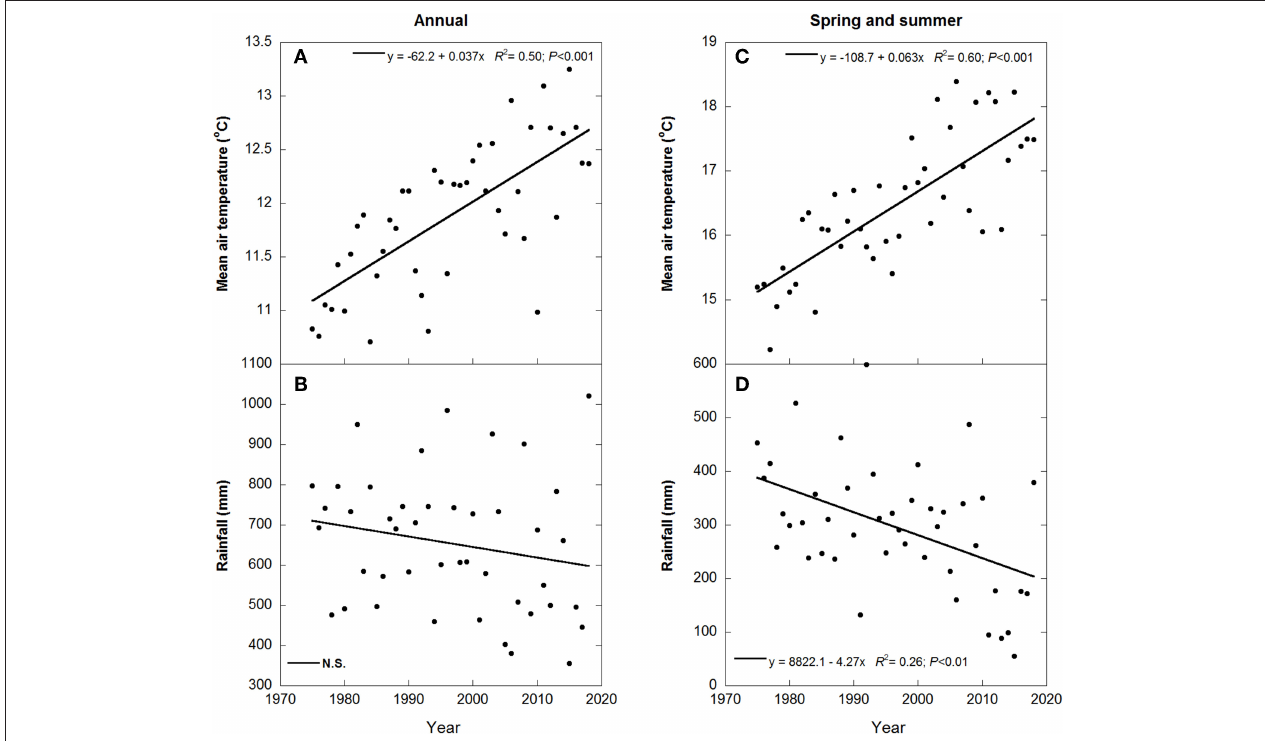
FIGURE 3 | Changes in mean air temperatures and rainfall during the period of collection of meteorological data. Mean annual temperature and total annual rainfall [ (A,B) , respectively] and spring and summer temperature and rainfall [ (C,D) , respectively]. N.S. indicates no significant relationship.